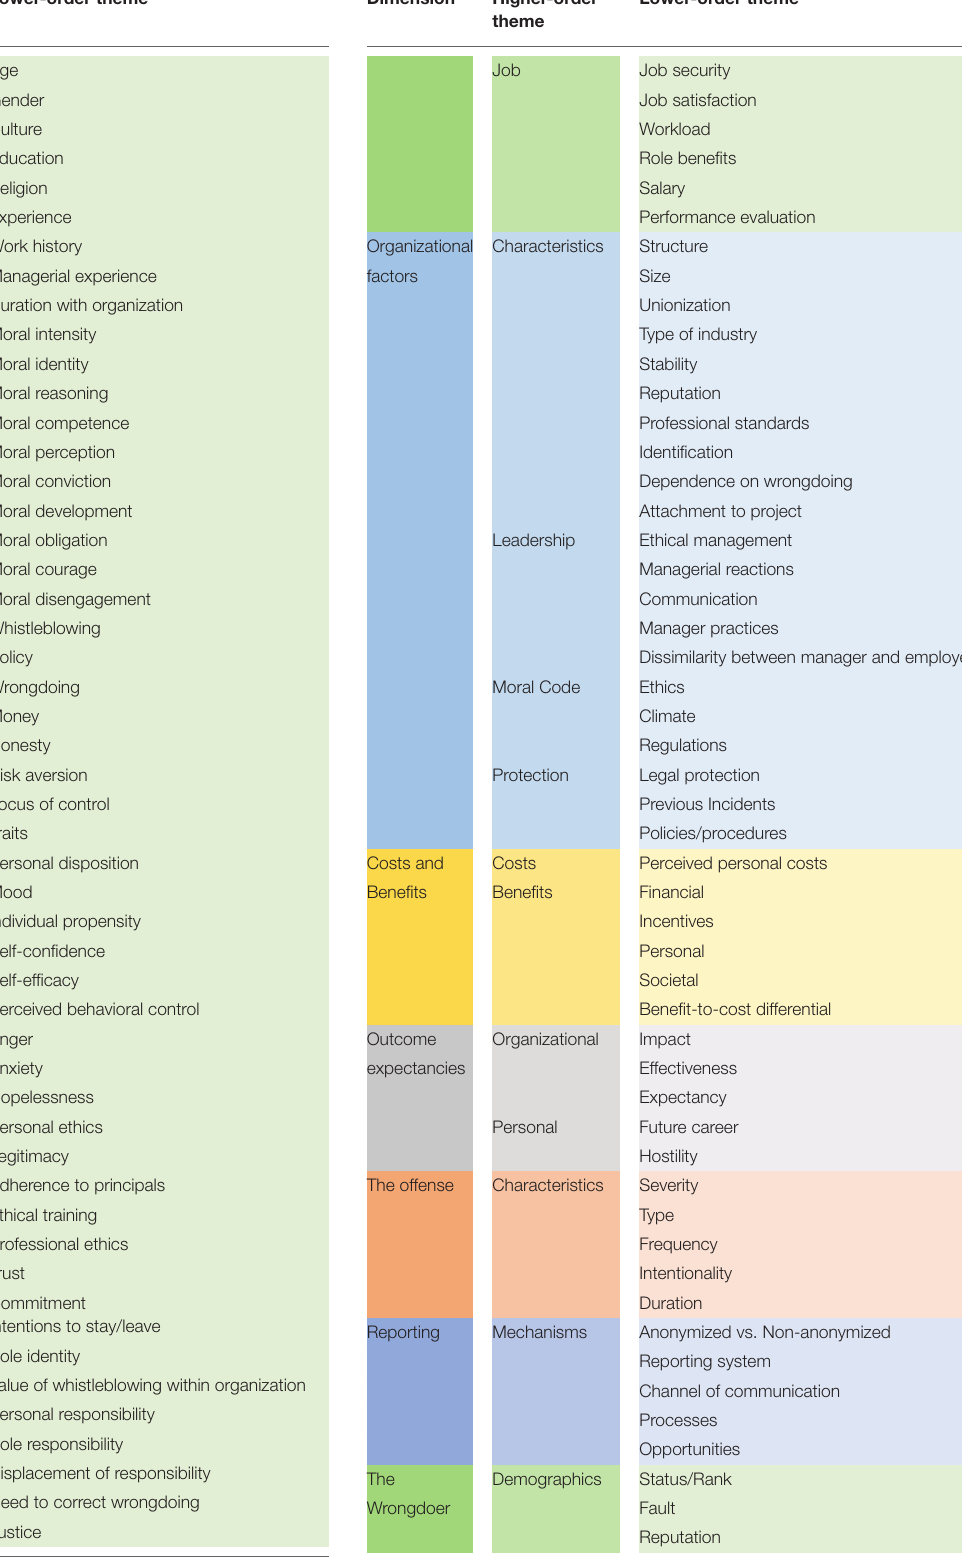
Dimension Higher-order